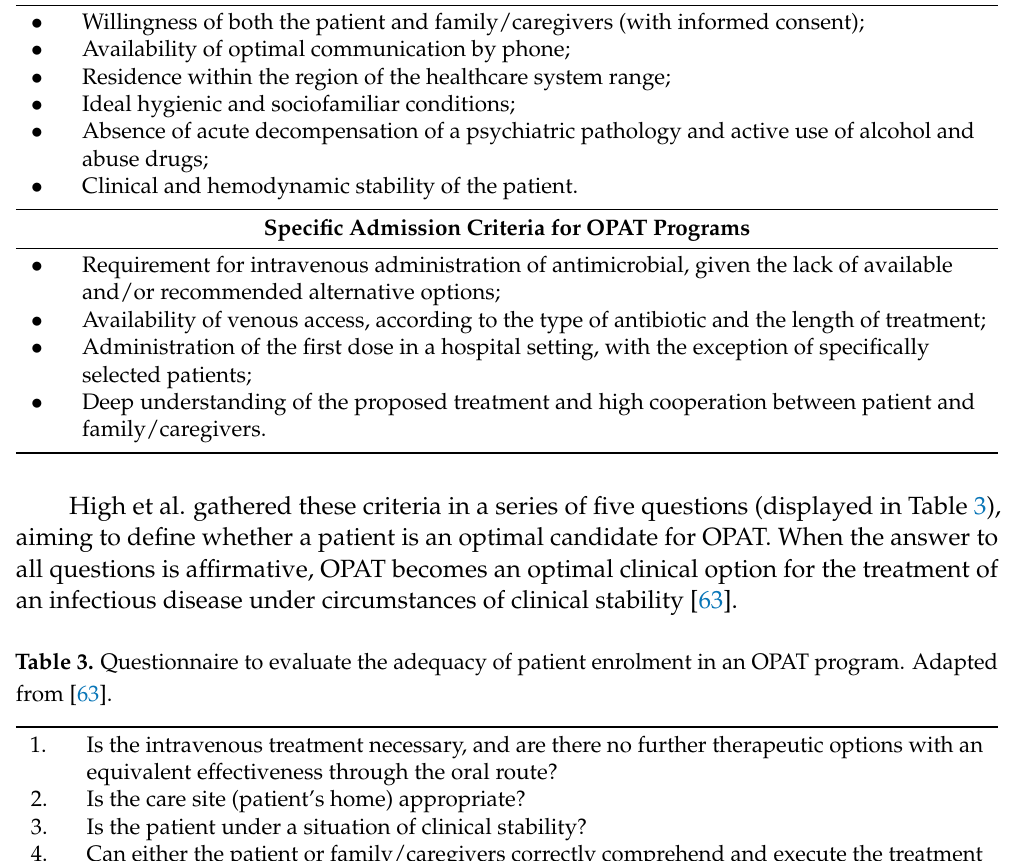
Table 2. General criteria for HaH and OPAT admission. Adapted with permission from [12]. General Criteria for Patient Admission in an HaH Unit